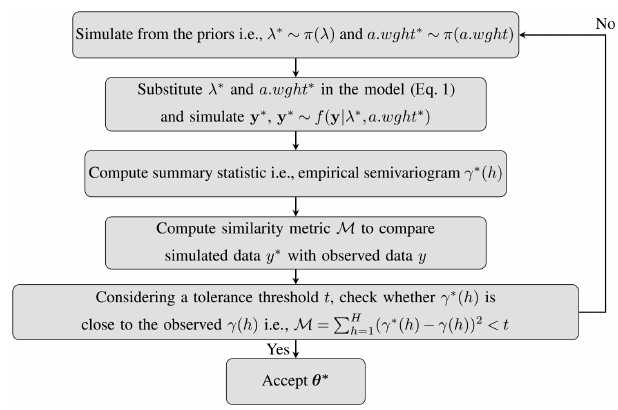
Figure 1. ABC acceptance–rejection algorithm using a variogram as a summary statistic for multi-resolution lattice